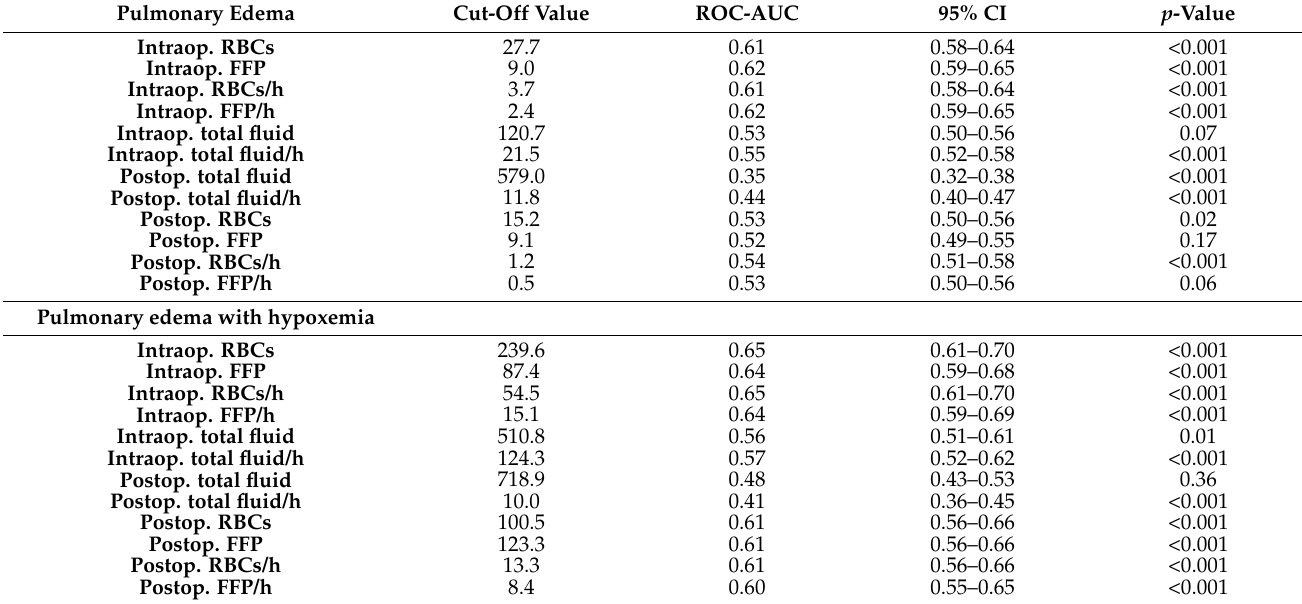
Table 3. Blood and fluid cut-off values for the development of pulmonary edema and pulmonary edema with hypoxemia. Pulmonary Edema